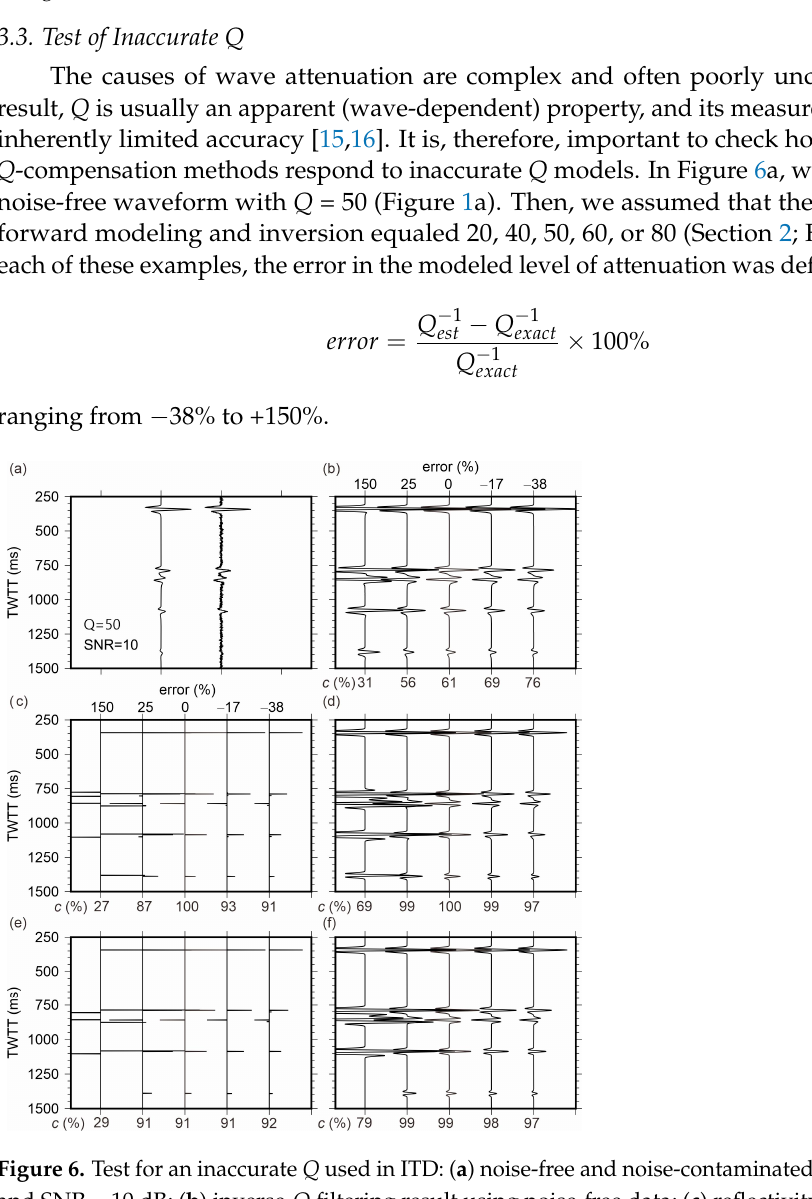
Figure 5. Reflectivity records obtained by ITD inversion, corresponding to Q -compensated waveforms in Figure 4: ( a ) Q = 10, ( b ) Q = 50.